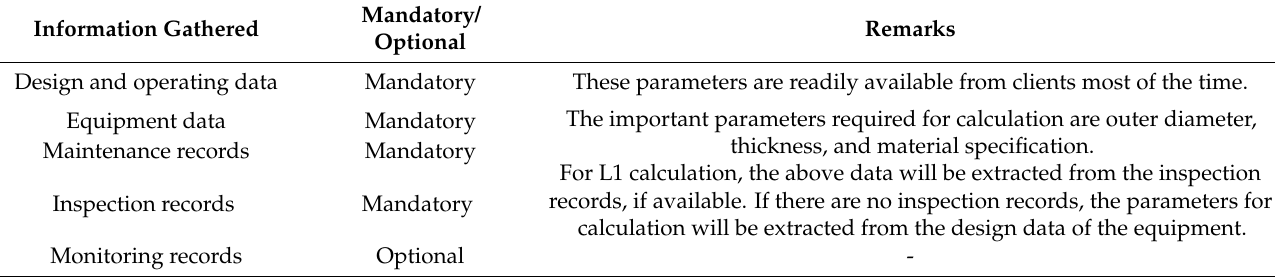
Table 1. Required information for